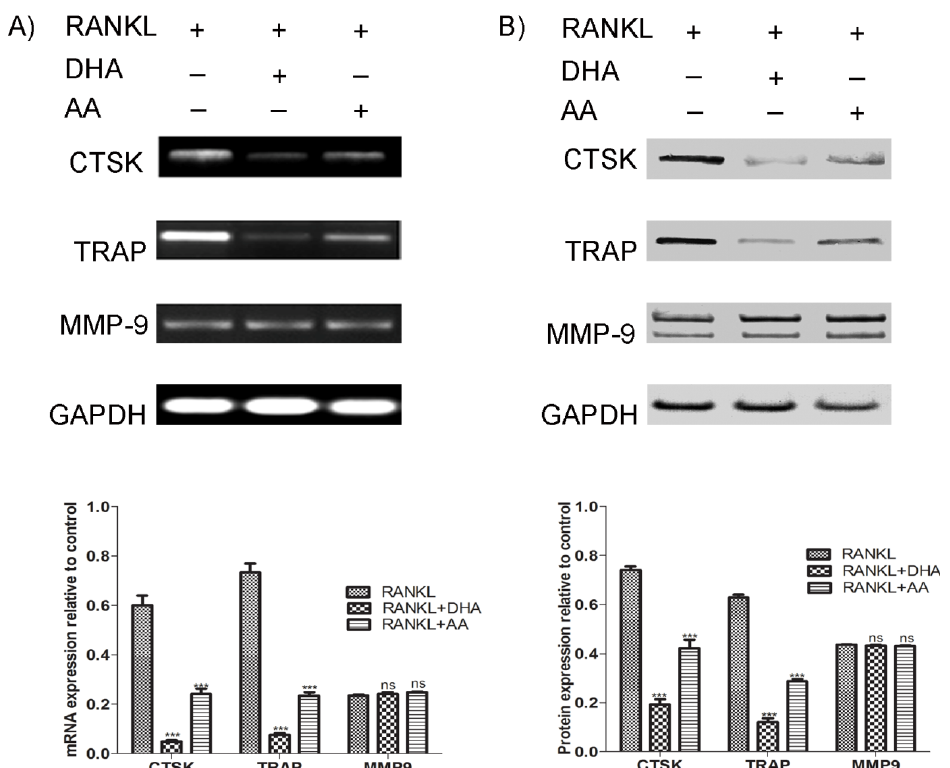
Figure 5. Effects of AA and DHA on RANKL-induced osteoclast specific gene